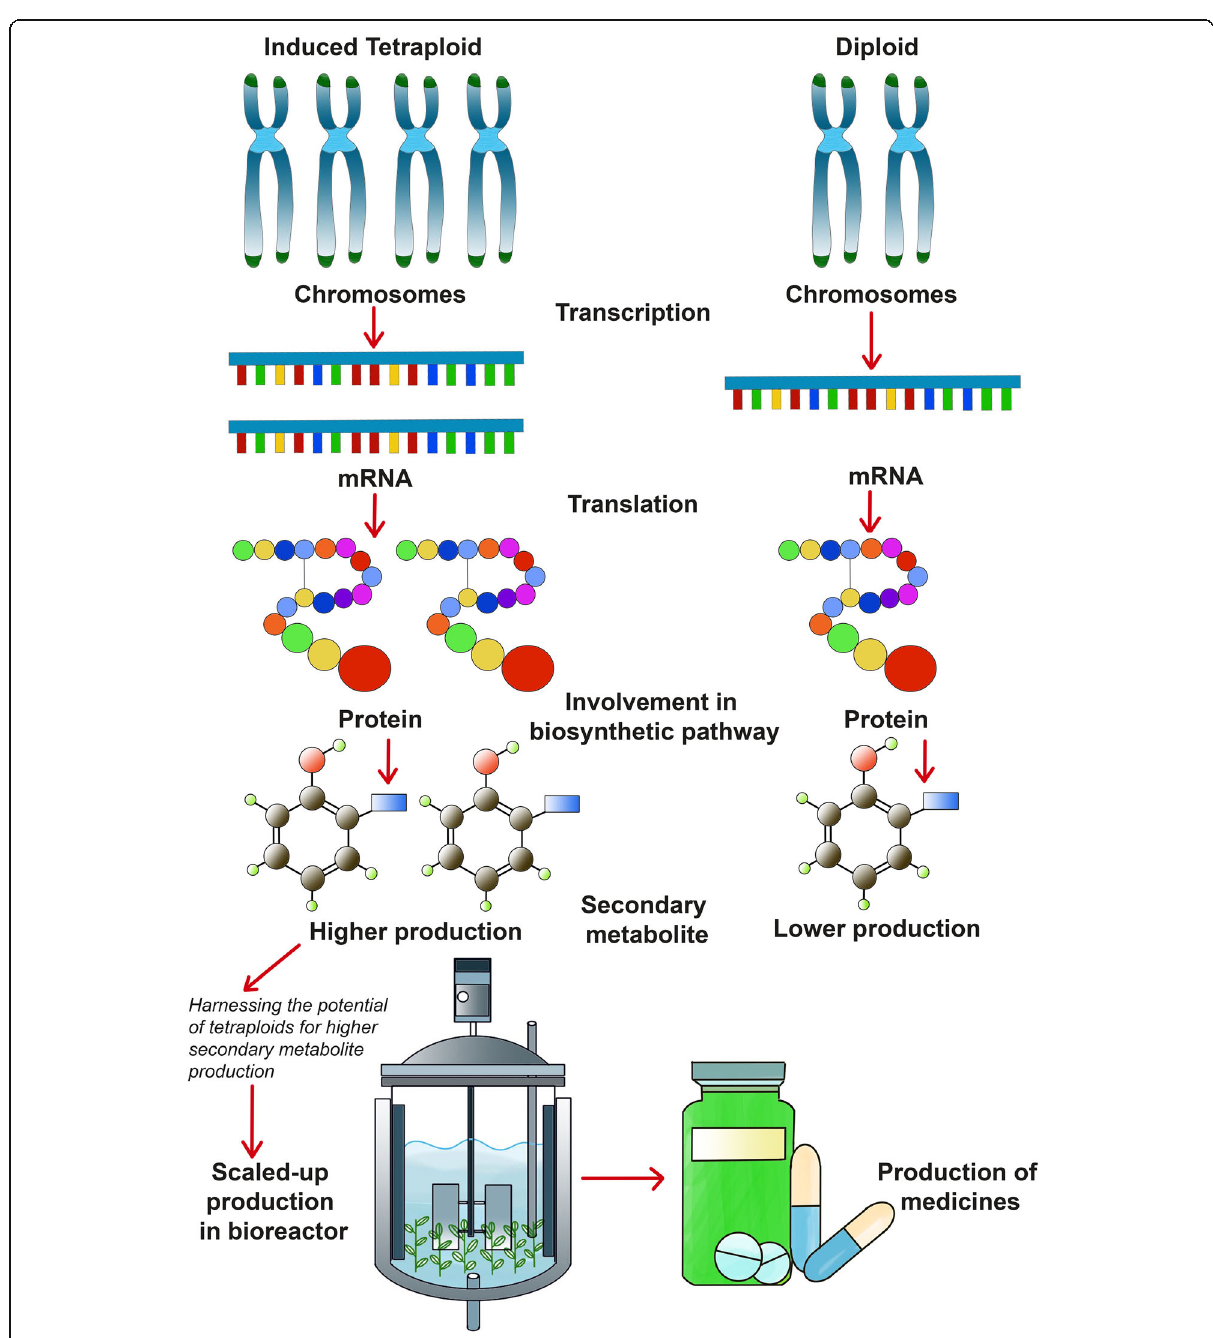
Fig. 2 Diagrammatic representation of difference in gene expression in autopolyploids and diploids leading to differential secondary metabolite production (diagram is not in scale) (Source: unpublished diagram of Saikat